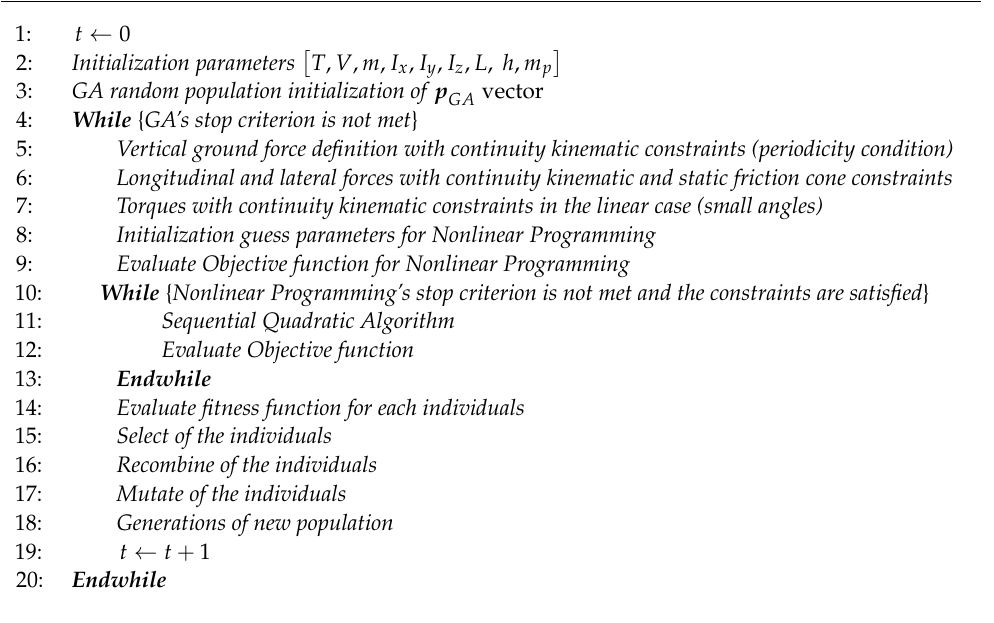
Algorithms 1 Pseudo code for the gait optimization algorithm